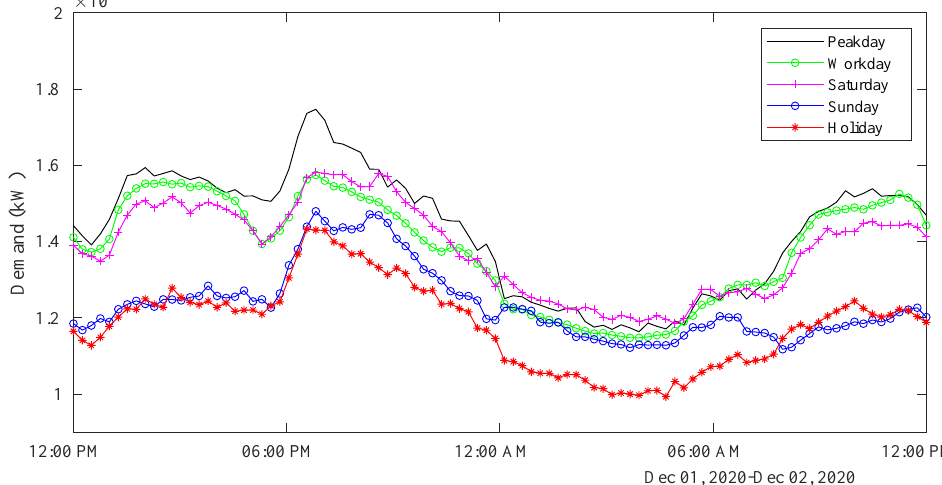
Figure 6. The PEA customer load demand in December